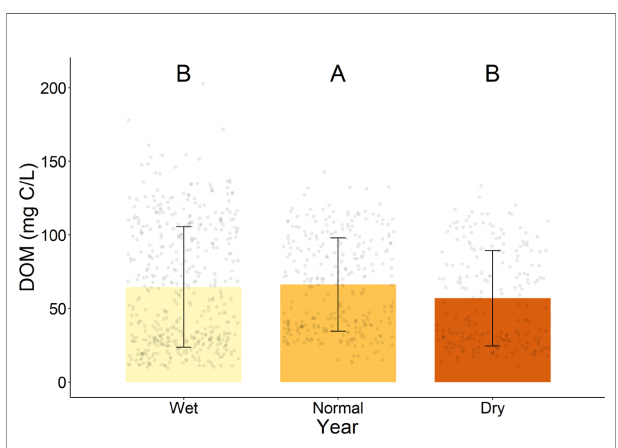
FIGURE 2 | Average and standard deviation of DOM concentration between years. Uppercase letters indicate statistically signi fi cant differences between years. Signi fi cant differences were determined by linear mixed models and Tukey-adjusted p-values for estimated marginal means (p < 0.05). Outlier calculation was not performed as there is temporal and spatial variation within each group which could be wrongly interpreted as